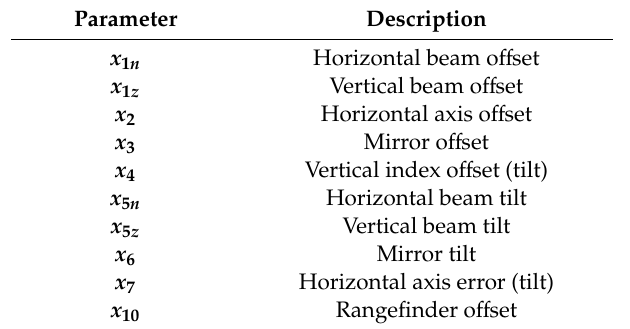
Table 1. The list of mechanical misalignments relevant for high-end TLSs.